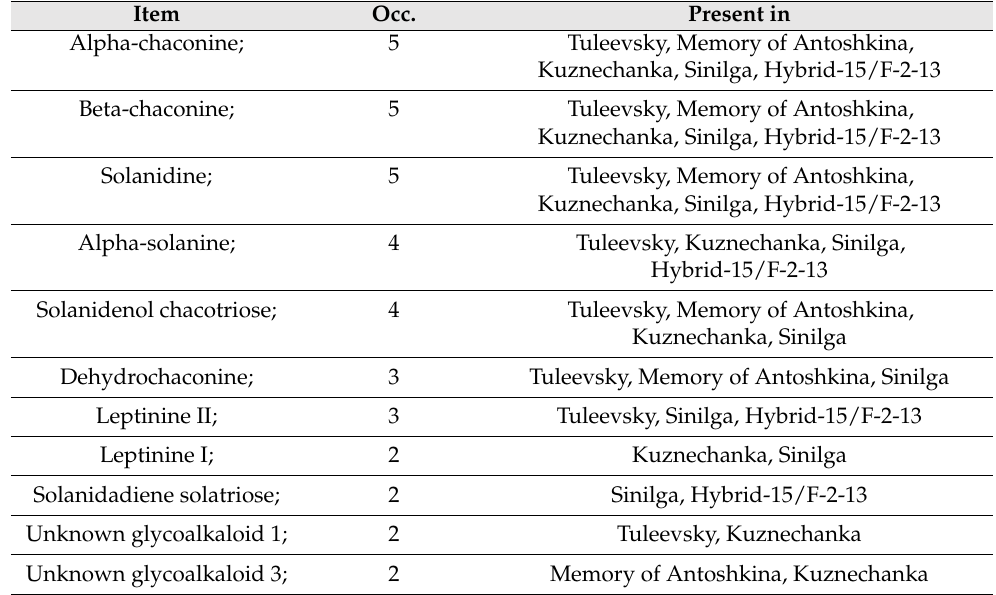
Figure 3. Venn diagram comparing the composition of isolated steroid alkaloids in potato samples “Tuleevsky”, “Memory of Antoshkina”, “Kuznechanka”, “Sinilga”, “Hybrid 15/F-2-13”. The detailed interpretation of the identified steroidal alkaloids in potato varieties is presented in Table 3.